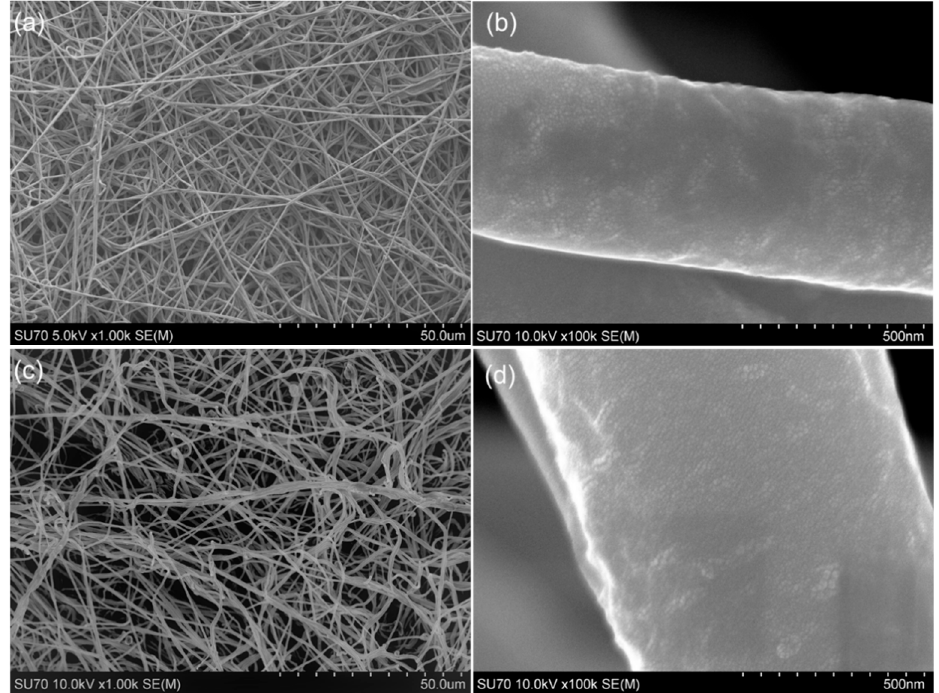
Figure 1. Surface morphology of scaffolds by SEM. ( a ) PCL nanofiber film, ×1.00k; ( b ) PCL nanofiber film, ×100k; ( c ) AMP-PCL surface, ×1.00k; ( d )AMP-PCL surface, ×100k.